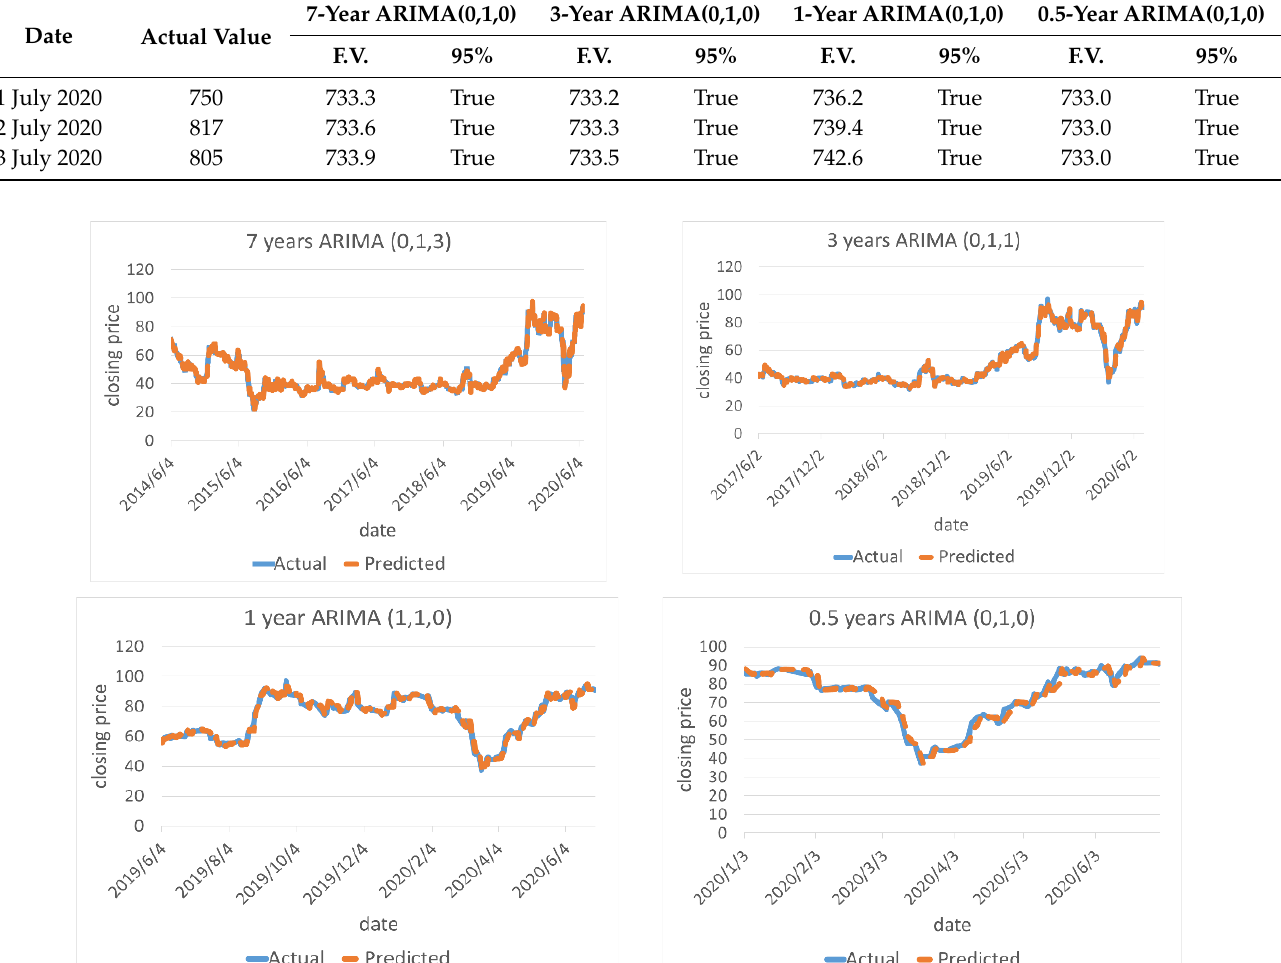
Figure 3. Prediction diagram of the optimal ARIMA model for 7, 3, 1, and 0.5 years for 3086 Wayi.